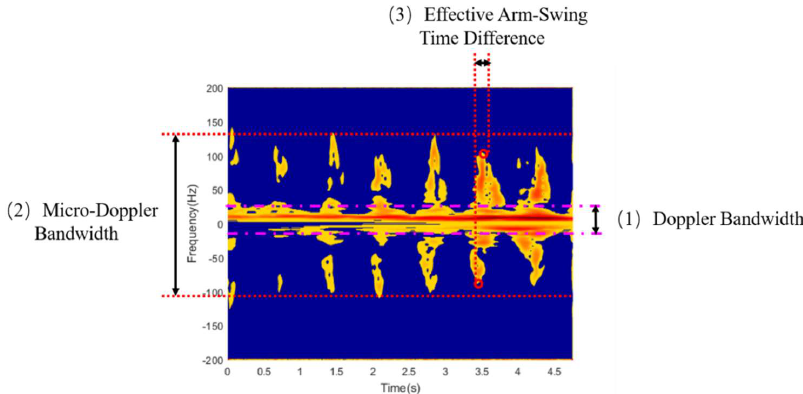
Figure 6. Three features selected from time-frequency distribution.